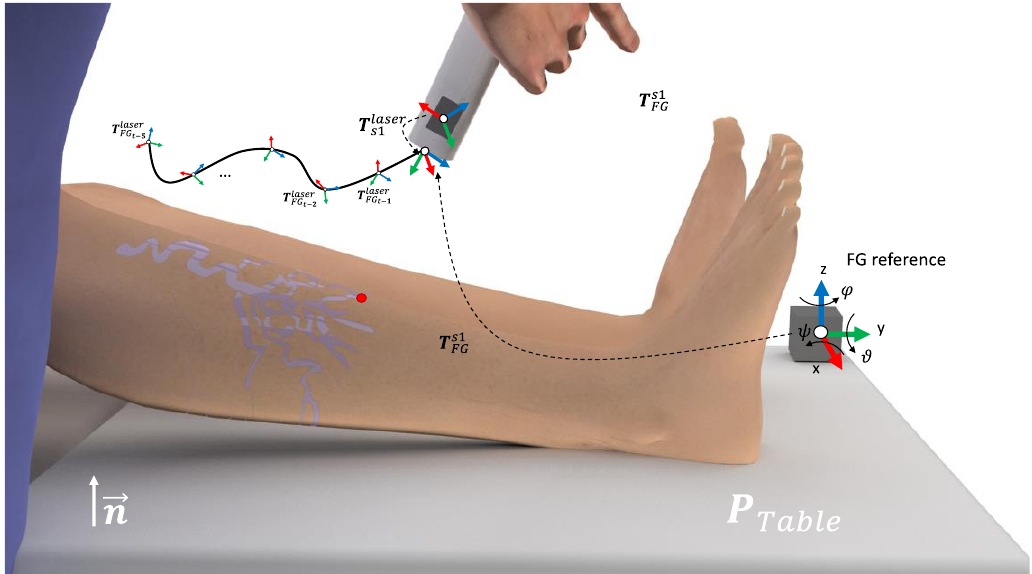
Figure 3. Representation of the monitoring setup of the vascular laser treatment. During the laser handling, the 3D position and orientation of the laser TCP is inferred and recorded. The red dot represents the laser projection on the patient’s leg.